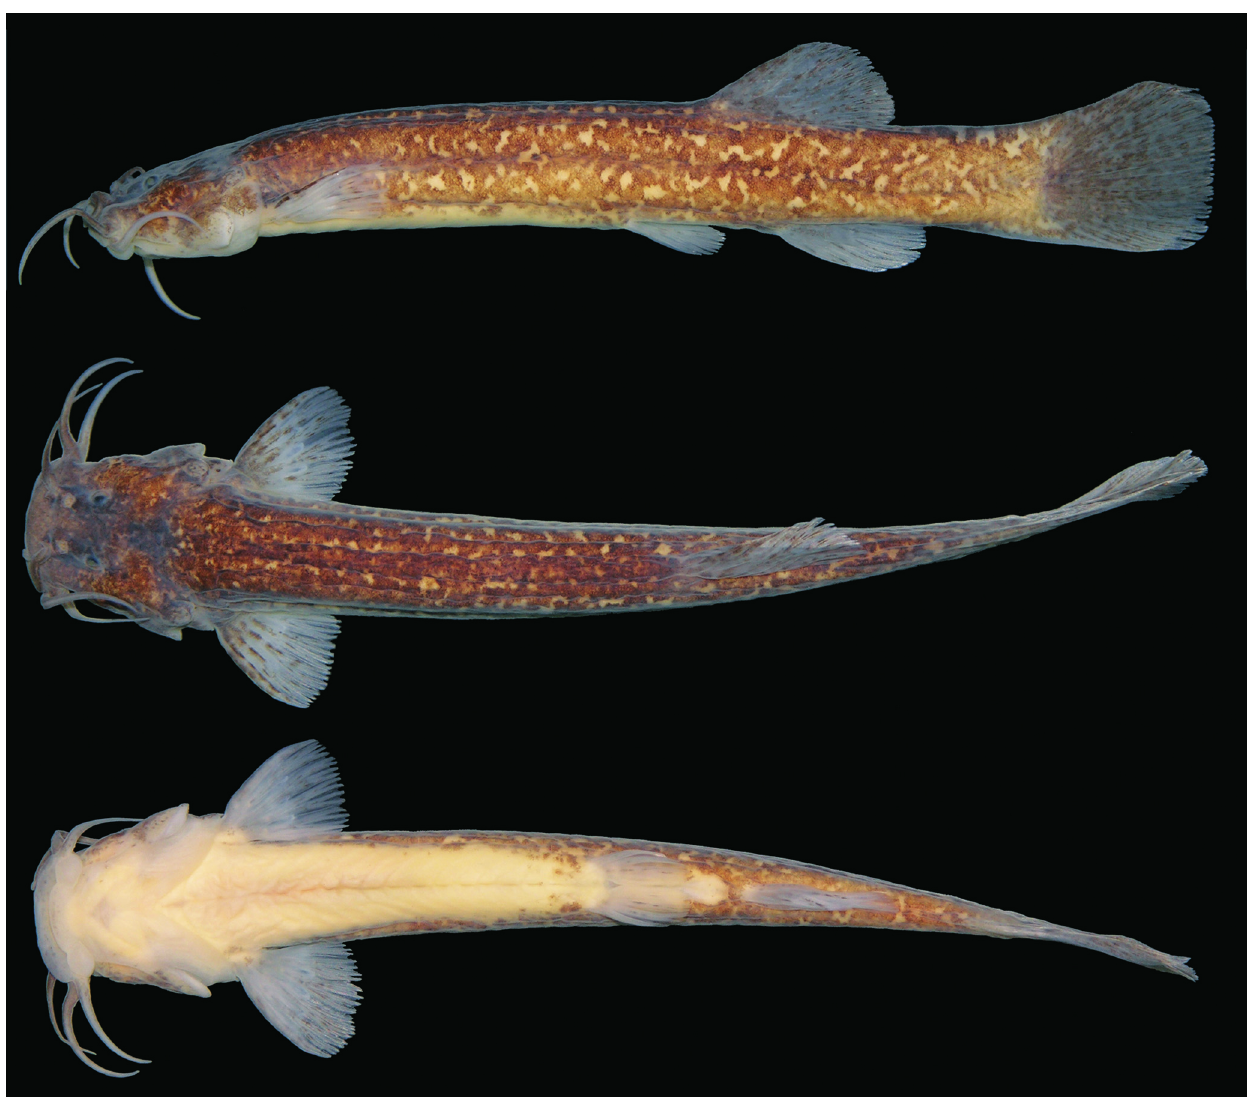
Fig. 15. Trichomycterus brachykechenos , holotype, MCN 18929, 61.1 mm SL, Brazil, Rio Grande do Sul State, municipality of Caraá, rio do